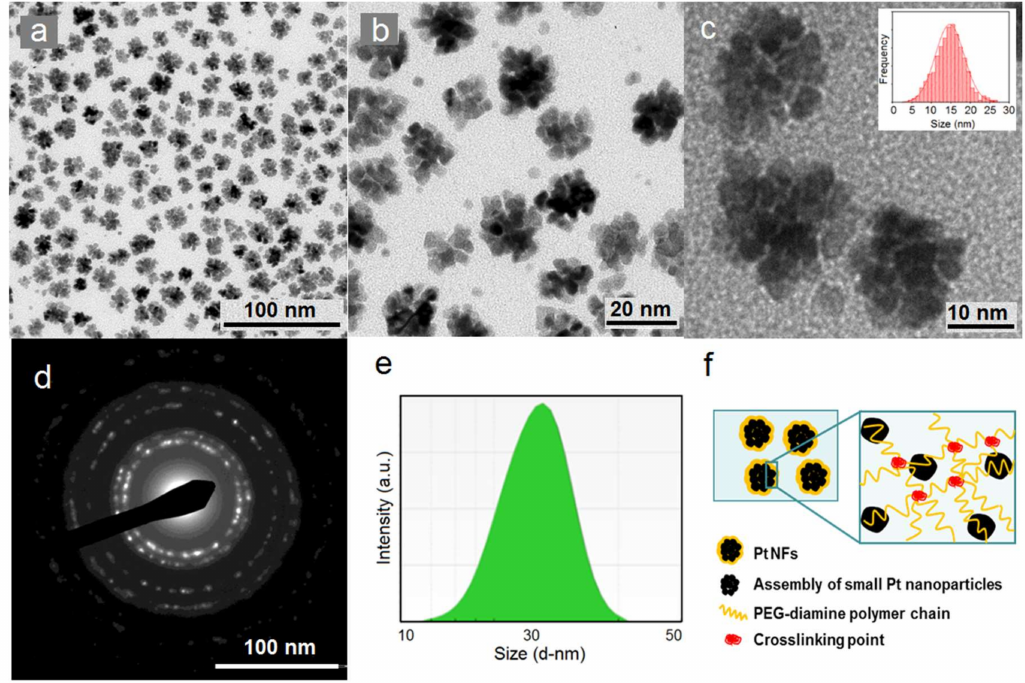
Figure 2. ( a – c ) Lower and higher magnification High-Resolution Transmission Electron Microscopy (HR-TEM) images of platinum nanoflowers (Pt NFs) and HR-TEM size distribution histogram of Pt NFs (inset); ( d ) Electron di ff raction pattern of Pt NFs; ( e ) Dynamic Light Scattering (DLS) size distribution by intensity of Pt NFs; ( f ) Scheme of the formation of Pt NFs by radiation-induced polymer cross-linking. The possible reaction and the evolution of Pt NFs were proposed as